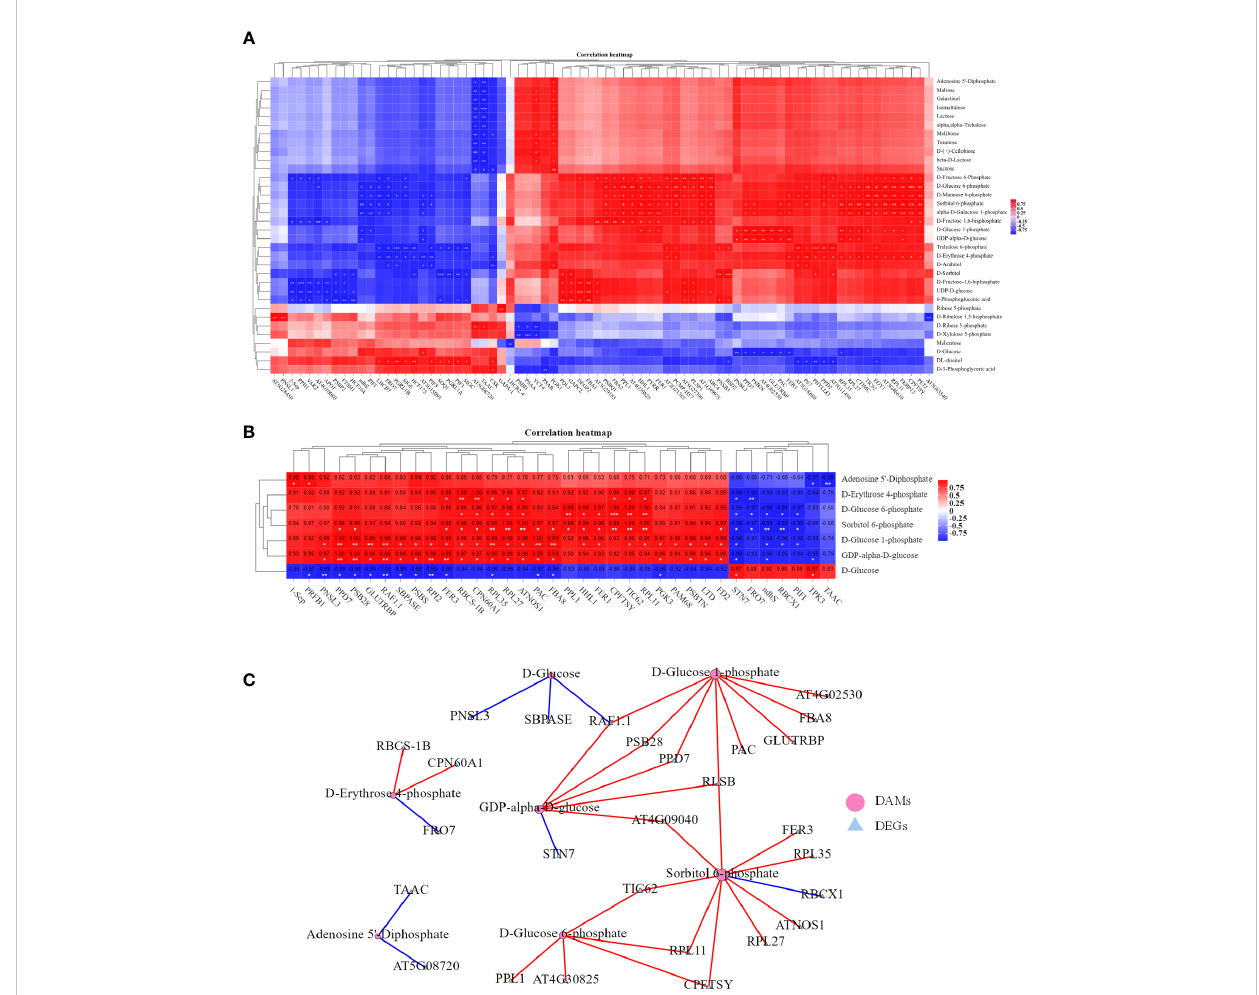
FIGURE 9 Correlation analysis of the transcriptome and metabolome pro fi les related to photosynthesis. (A) Pearson correlation analysis between photosynthesis-related DAMs and DEGs of the three treatments (BL + Pyr, BL and Pyr) versus the untreated group with correlation coef fi cient >0.99 and p-value<0.01. (B) Pearson correlation analysis between the unique photosynthesis-related DEGs and unique photosynthesis-related DAMs of the BL+Pyr group with correlation coef fi cient >0.95 and p-value<0.05. (C) The correlation network plot displaying the highly signi fi cant correlation pairs between the unique photosynthesis-related DEGs and unique photosynthesis-related DAMs of the BL+Pyr group with Pearson ’ s correlation coef fi cient >0.99 and p-value<0.01. Metabolite and transcriptome data were log2-transformed prior to correlation analysis. “ * ” represented 0.01< p- value<0.05, “ ** ” represented 0.001< p-value<0.01 and “ *** ” represented p-value ≤